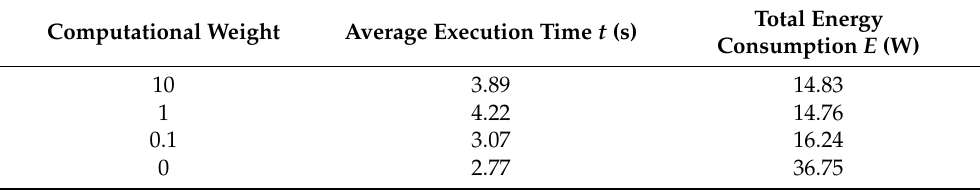
Table 7. Execution time and energy consumption applying the GA algorithm.